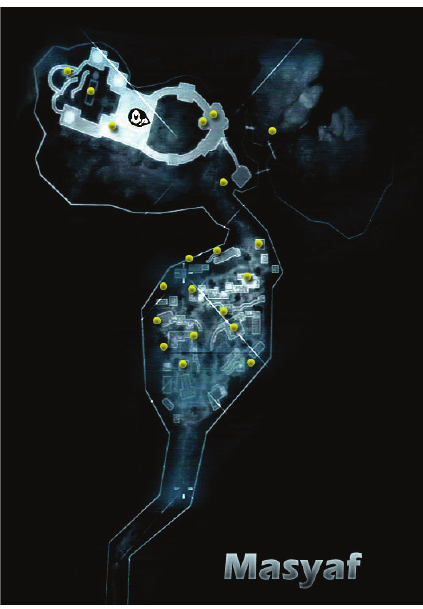
Figure 1: Masyaf town in Assassin’s Creed (source: Ubisoft, 2007; image from IGN.com, used with